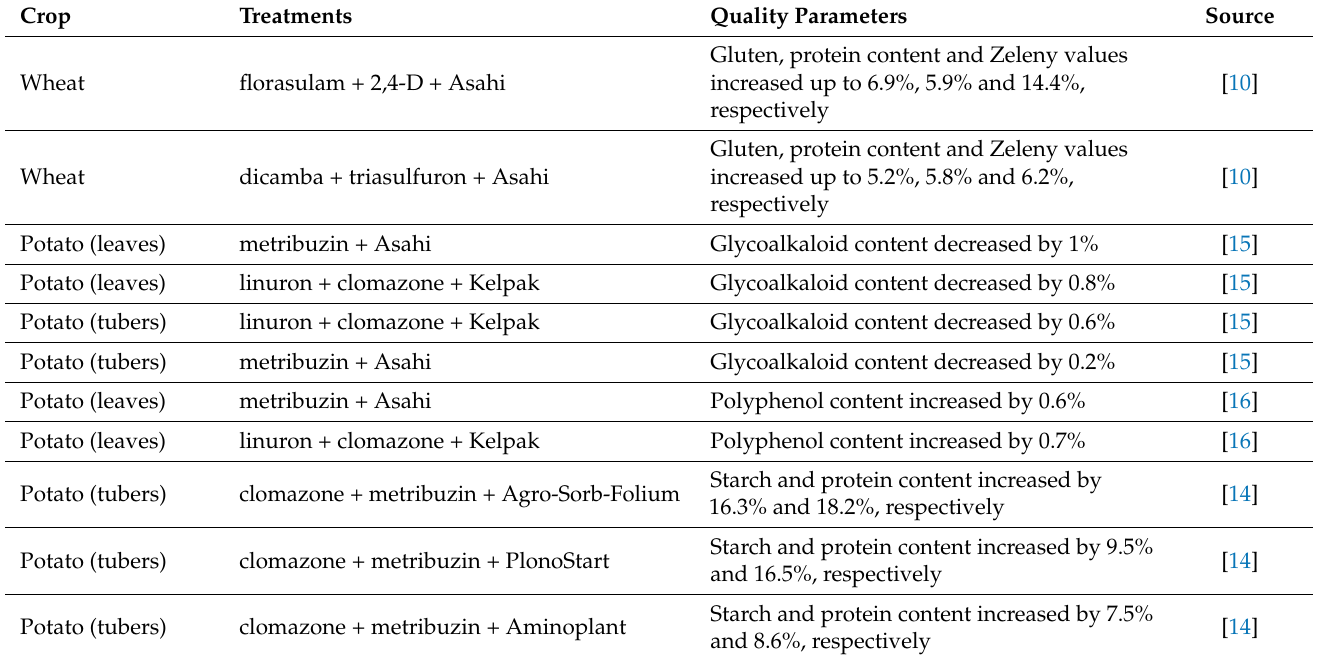
Table 3. Effects of the combined use of biostimulants and herbicides on quality parameters of different crops and products compared to the use of the respective herbicides alone (without biostimulants). Quality Parameters Source Gluten, protein content and Zeleny